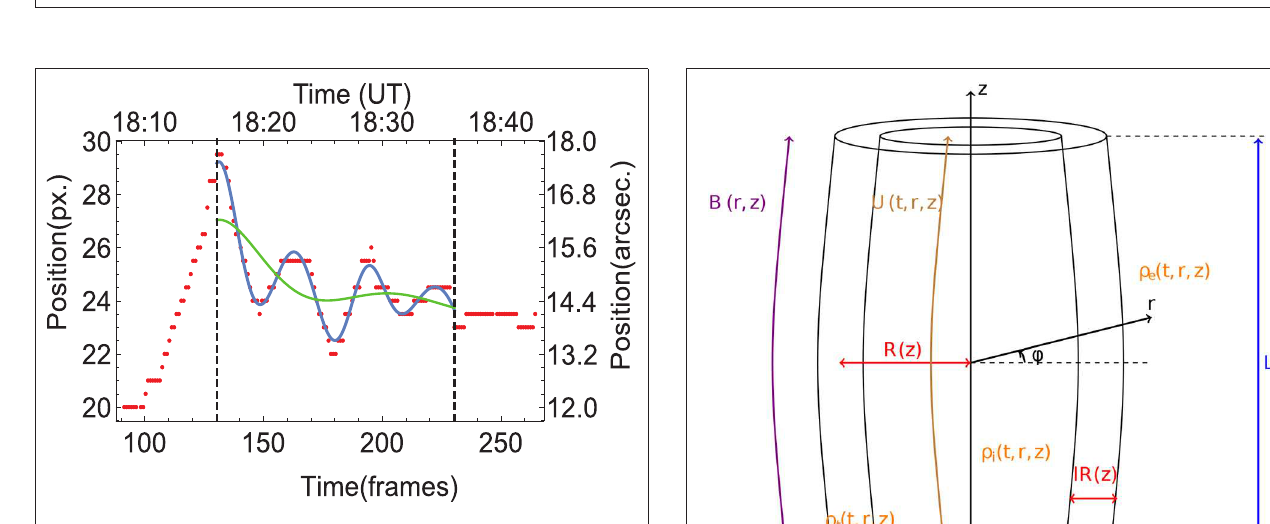
FIGURE 4 | The position-time dependence of the coronal loop. Red dots correspond to data points collected from the 171 Å time-space diagram plotted in Figure 3 . The green line corresponds to the fitted 8th-order background trend and the blue line is the Gaussian fit of the observed data points computed of the form (Equation 1). The two vertical dashed lines indicate the boundaries of the area over which numerical fitting took place. The Gaussian fit under-estimates the oscillation amplitude between frames 170 and 200 meaning the amplitude at this time will be under-estimated.